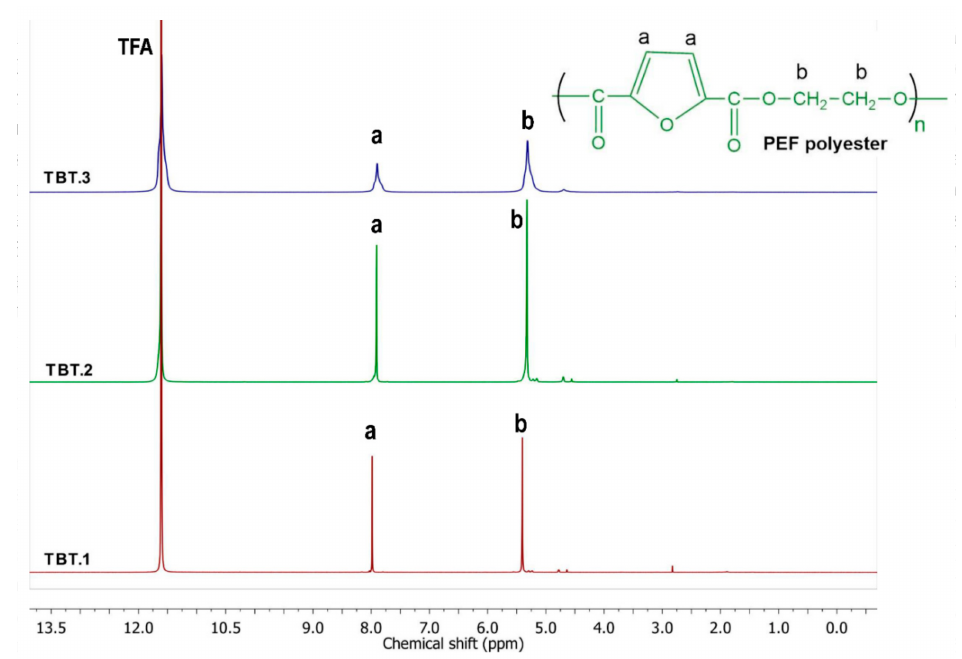
Figure 1. 1 H NMR spectra of poly(ethylene furanoate) (PEF)/ tetrabutyl titanate (TBT)